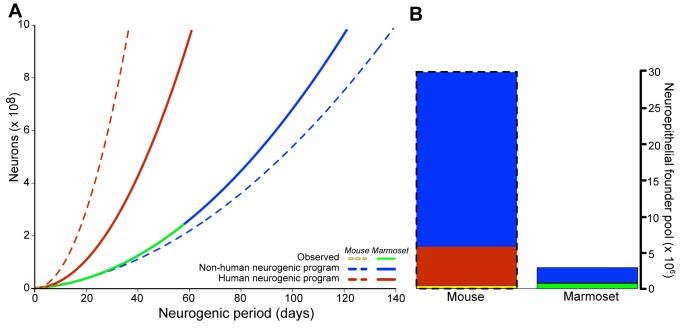
Mouse and marmoset, both low-GI species, may generate 109 neurons more efficiently by adopting the human neurogenic program than by extending neurogenic period or expanding neuroepithelial founder pool size.(A) Using its observed neurogenic program (yellow dashed line), the mouse may achieve 109 neurons by extending its observed neurogenic period 14-fold (blue dashed line) or, by using the human neurogenic program (red dashed line), 4-fold. Similarly, the marmoset (green solid line) may achieve 109 neurons using the human neurogenic program (solid red line) in 50% of the time it would take using its observed neurogenic program (solid blue line). (B) The barplot shows the amount by which both species' neuroepithelial founder pools would have to increase to achieve 109 neurons using either their observed (blue) or the human (red) neurogenic program. In (A) and (B), yellow and green line endpoints (A) and bar heights (B) represent observed values for mouse and marmoset, respectively. See Table S4 for primary data and estimates.